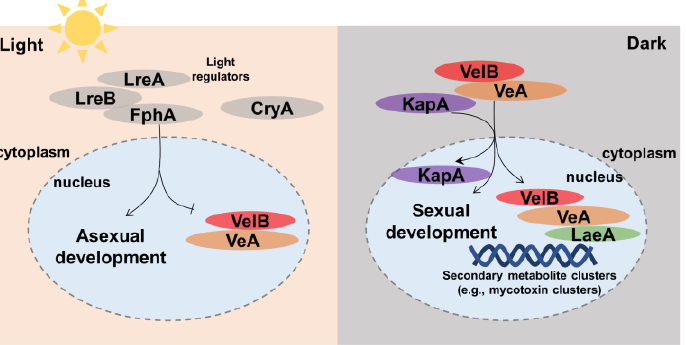
Figure 7. Velvet complex responses to light/dark condition and regulates mycotoxin biosynthesis.